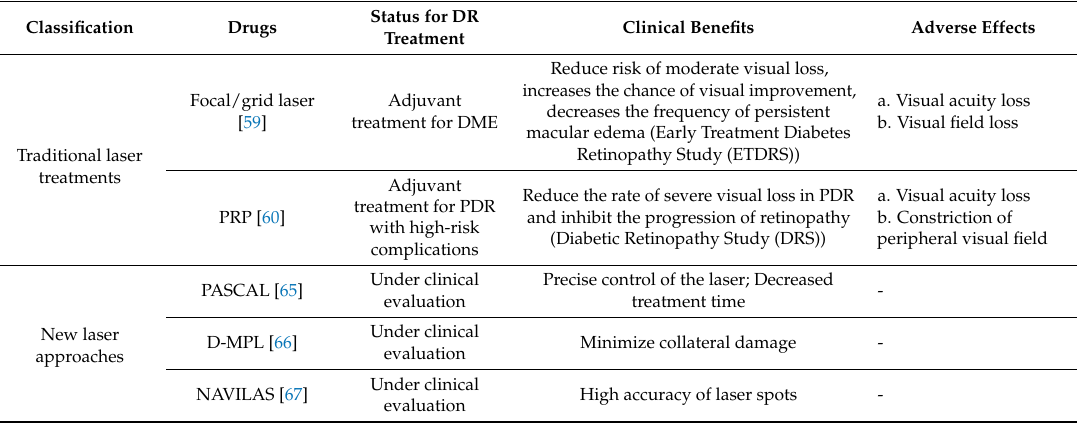
Table 3. Laser photocoagulation for the treatment of DR.